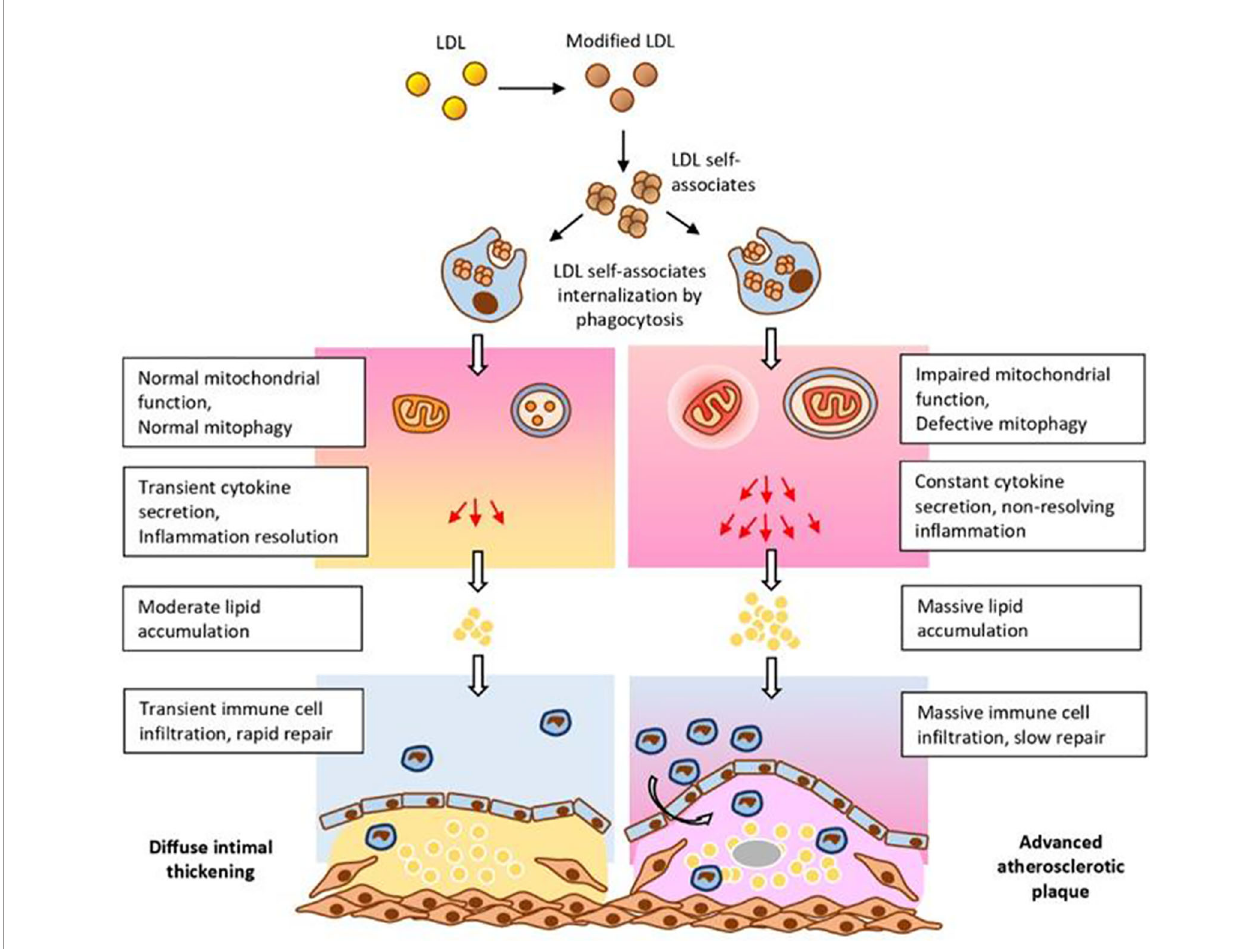
FIGURE 2 | Impaired mitochondrial function and de fi cient mitophagy promote atherosclerotic lesion formation. Multiply modi fi ed LDL particles being accumulated and then internalized by macrophages are capable to alter mitochondrial function which ultimately leads to the formation of atherosclerotic plaques. From Orekhov et al. (2020a), with